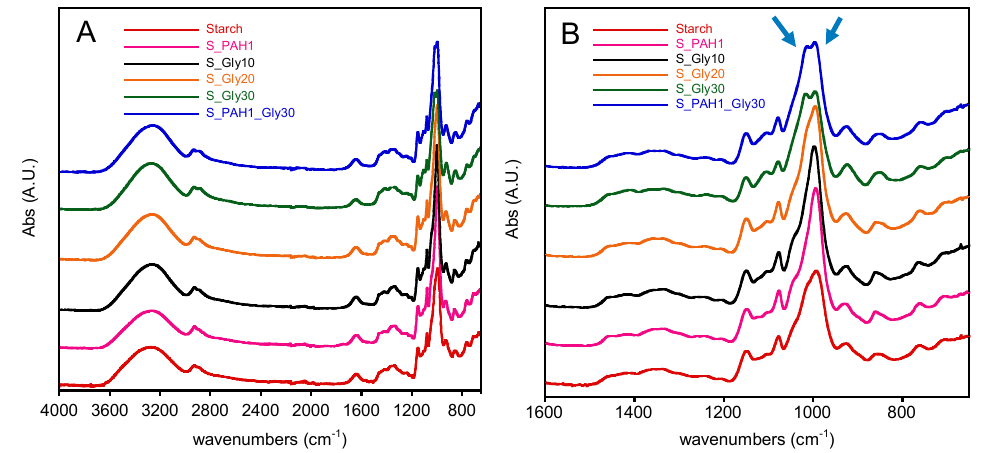
Figure 4. FTIR spectra ( A ) of starch, glycerol-plasticized starch films (S_Gly10, S_Gly20 and S_Gly30), PAH containing-starch film (S_PAH1) and starch film containing both 1% PAH and 30% Gly (S_PAH1_Gly30). Enlargement of the 1600–650 cm-1 spectral range ( B ). Arrows indicate peaks at 995 cm − 1 and 1015 cm − 1 .